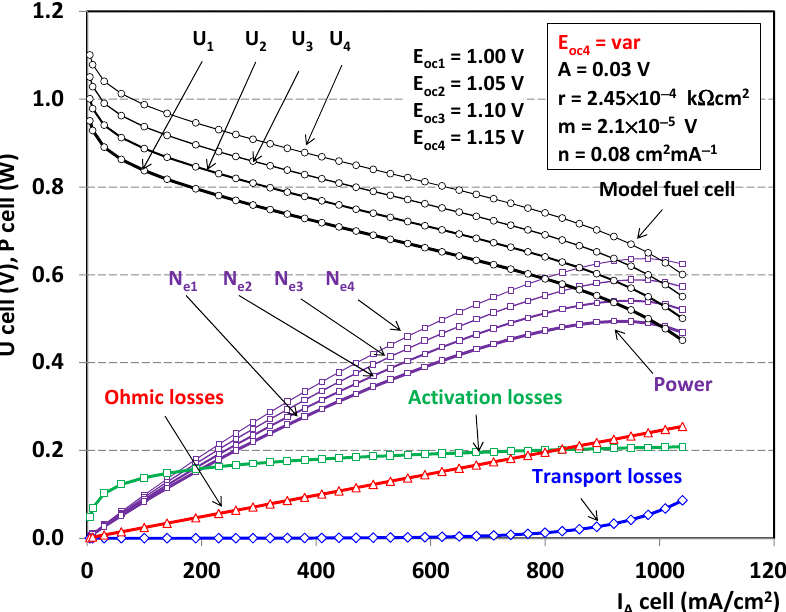
Figure 5. Influence of fuel cell E OC open circuit voltage on the fuel cell characteristics and losses.